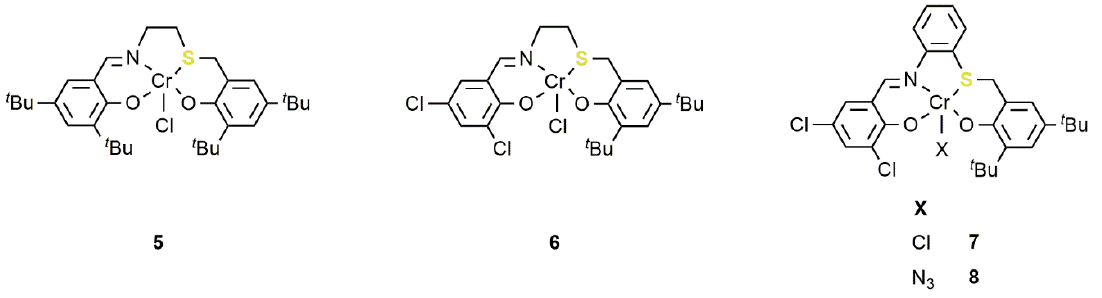
Figure 9. Chromium(III)-[ONSO] catalysts 5–8 [60].